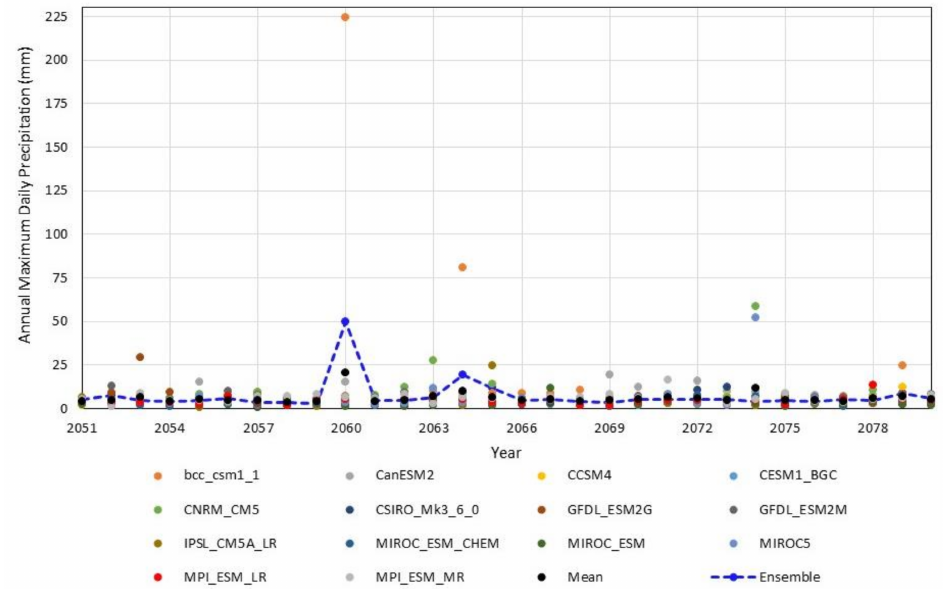
Figure 18. Annual maximum daily precipitation projected by 14 climate models under the RCP8.5 scenario for the Devil’s Creek. The dashed blue line corresponds to the ensemble. Period: 2051–2080.